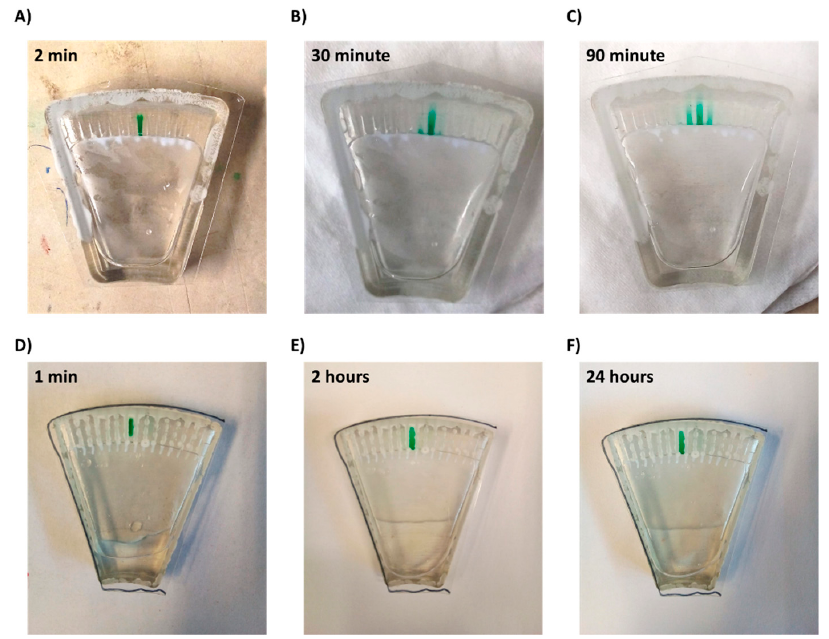
Figure 4. Diffusion of a drop-dried dye from a microchannel within the chip. ( A – C ) Chip without superhydrophobic and hydrophilic coatings and ( D – F ) chip with coatings.